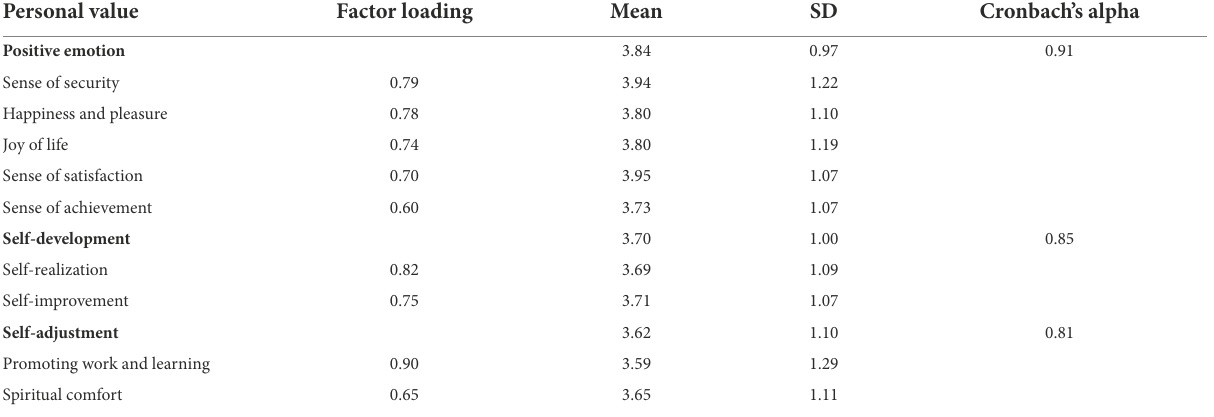
TABLE 5 Factor loading of personal